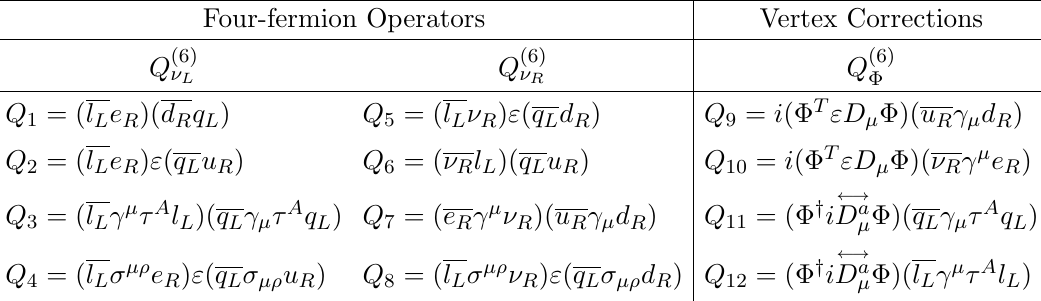
Table 1. Dimension-six operators relevant for neutrino capture. Here l L ; q L are the SM lepton and quark SU(2) L doublets while u R ; d R ; e R ; (cid:23) R are the corresponding SM singlets. The SU(2) L generators are denoted with (cid:28) A while " ij is the totally antisymmetric tensor with " 12 = +1. We do not include the invariant operator ( (cid:23) R (cid:27) (cid:22)(cid:26) l L )( q L (cid:27) (cid:22)(cid:26) u R ) in the list because it does not contribute to the relic